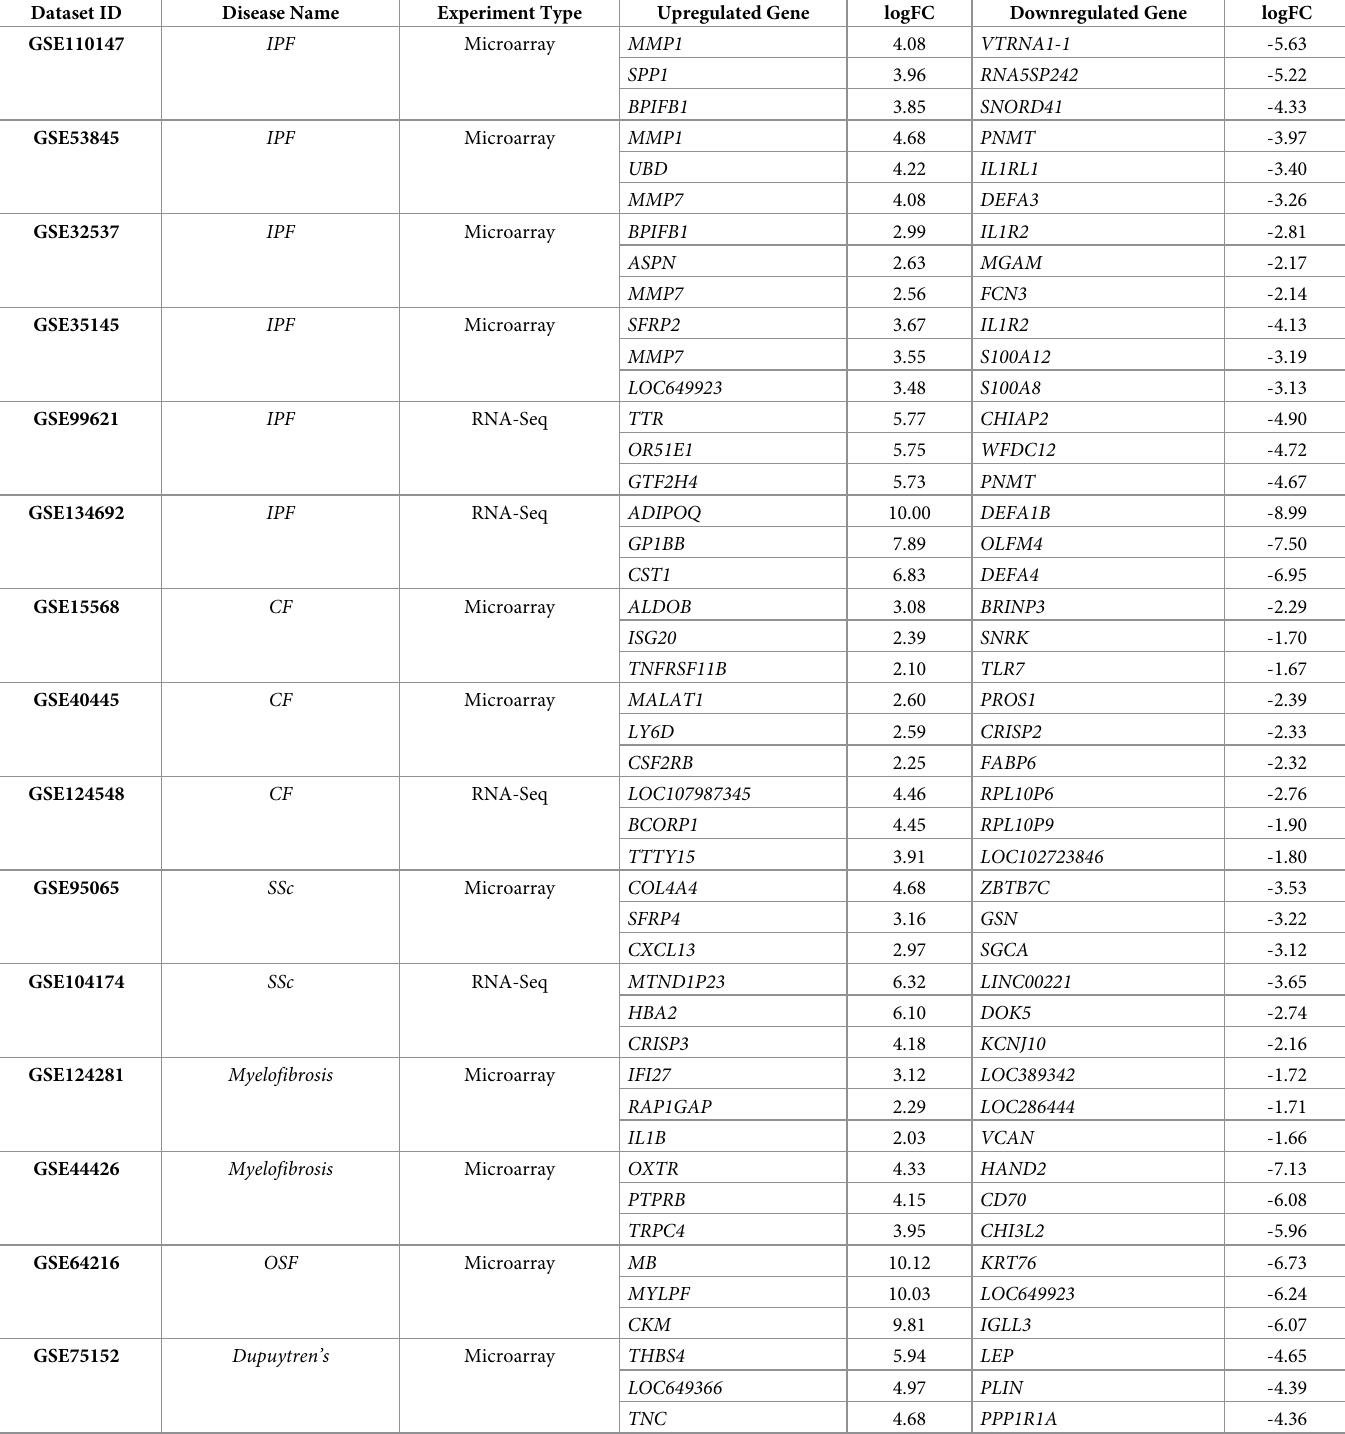
Table 3. Top-3 over- and top-3 under-expressed genes of each experiment based on their logFC values. Dataset